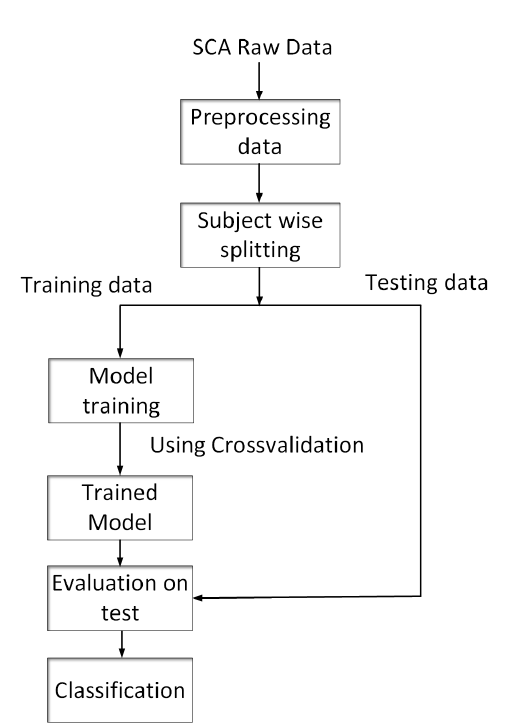
Figure 5. The process of building a CNN-based machine learning model.